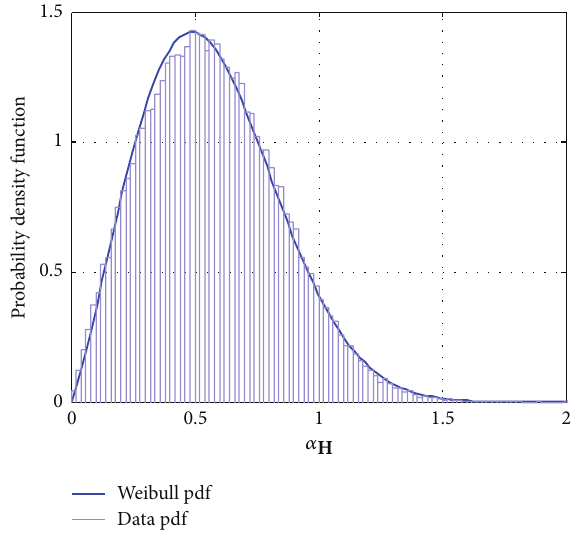
Figure2:Theprobabilitydensityfunctionof 𝛼 H .Thepdfismodeled as a Weibull random variable with a scale parameter 𝜆 = 0.644 and a shape parameter 𝑘 = 2.20 . The results are averaged over 100,000 independent trials, where the mean and variance of 𝛼 H are approximately given by 0.57 and